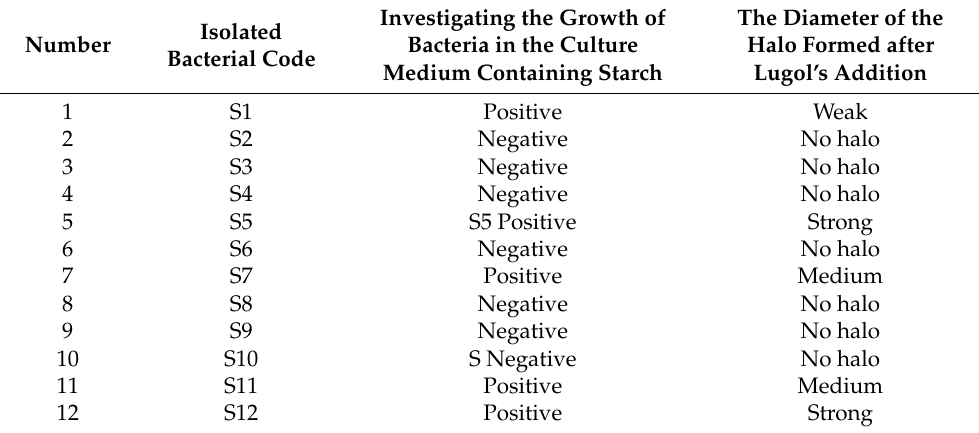
Table 2. Assessment of bacterial strains capable of generating α -amylase from the intestines of Rastrelliger kanagurta . The Diameter of the Investigating the Growth of Isolated Halo Formed after Bacteria in the Culture Number Bacterial Code Lugol’s Addition Medium Containing Starch 1 S1 Positive Weak 2 S2 Negative No halo 3 S3 Negative No halo 4 S4 Negative No halo 5 S5 S5 Positive Strong 6 S6 Negative No halo 7 S7 Positive Medium 8 S8 Negative No halo 9 S9 Negative No halo 10 S10 S Negative No halo 11 S11 Positive Medium 12 S12 Positive